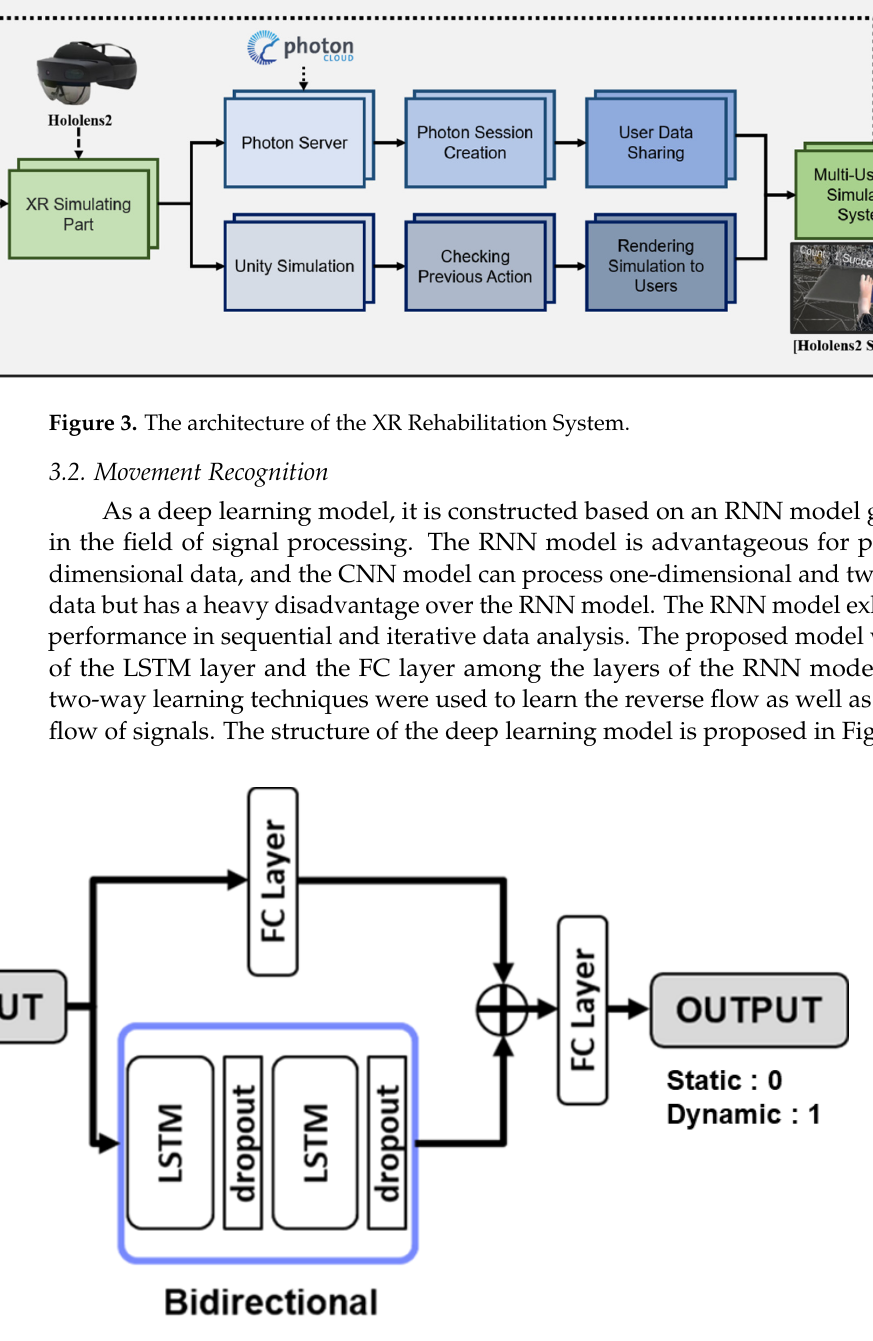
Figure 4. Proposed Deep-Learning Model Structure.